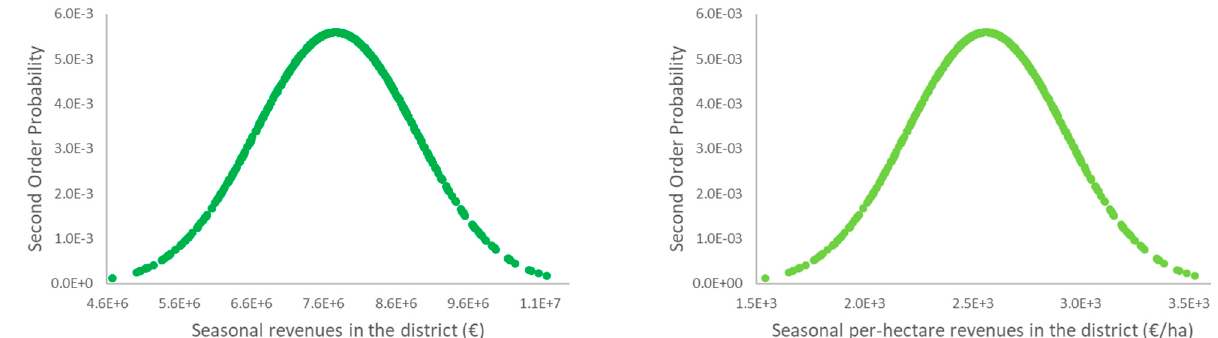
Figure 4. II Order PDF of revenues in the district for the period March–April. Table 2. Parameters of the II Order PDF representing ambiguity in the district.